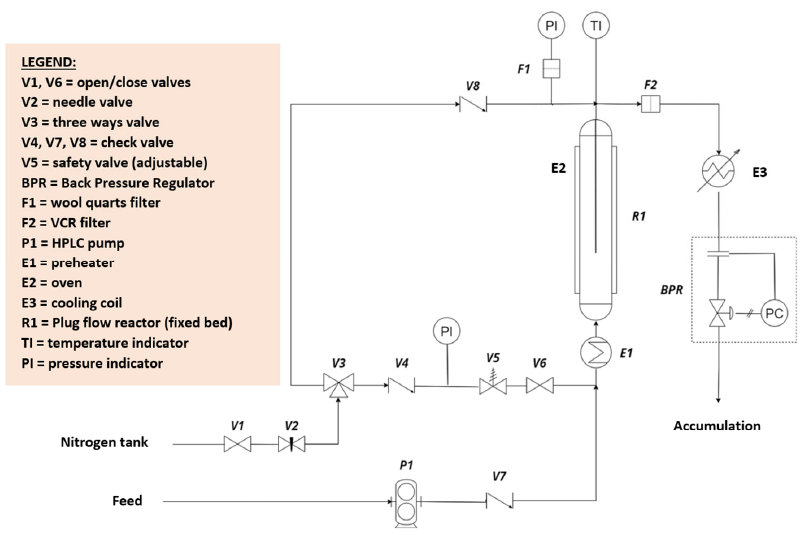
Figure 2. Scheme of the liquid ‐ phase continuous plant used.